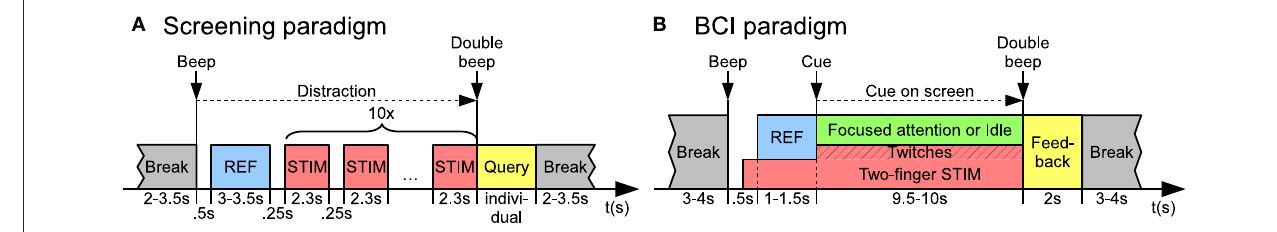
FIGURE 1 | Experimental paradigms. (A) In the screening paradigm, each trial started with a reference (REF) period, followed by 10 stimulation (STIM) intervals with frequency and index finger randomly chosen. Subjects had to perform a distracting mental arithmetic task during the whole trial. At the end of each trial, they were asked for their calculation results. (B) In the online BCI paradigm, both index fingers were simultaneously stimulated. Each trial started with a reference period, followed by a focused attention or idle period, as indicated by a cue appearing on the screen. Twitches were only presented during this period (hatched area). At the end of each trial, a discrete feedback was given on the